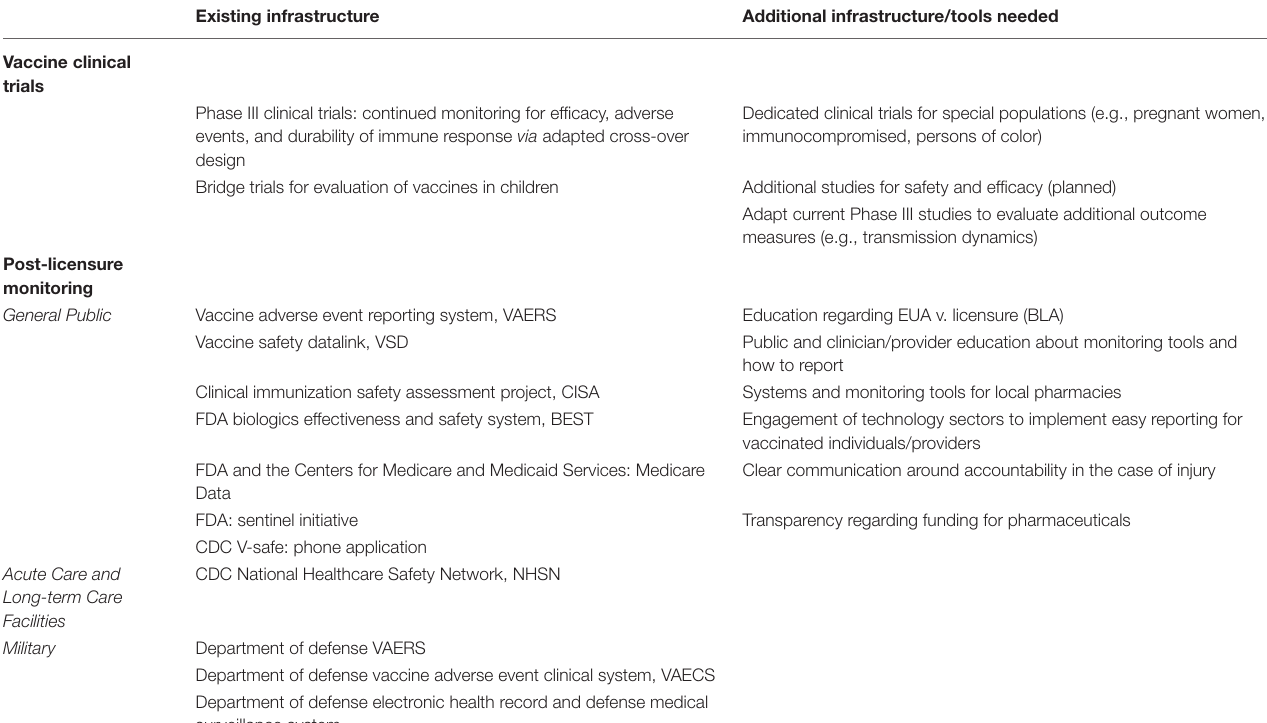
TABLE 1 | Existing and needed infrastructure to target concerns about COVID-19